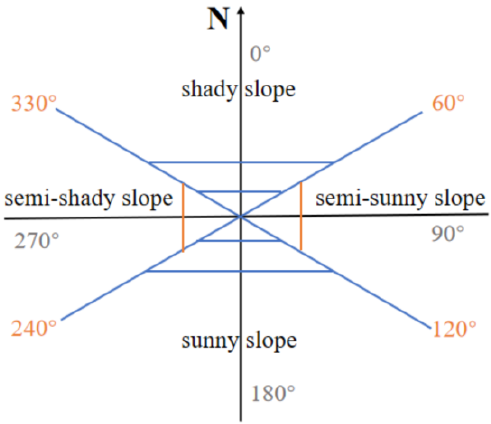
Figure 4. The schematic diagram of four aspect grades.